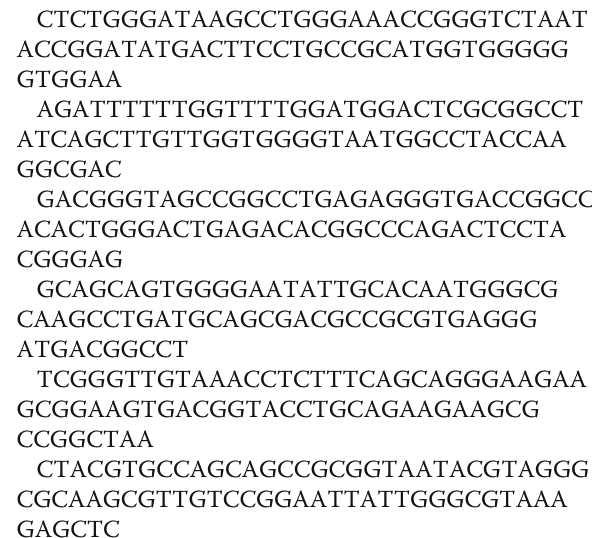
Results are expressed as antagonistic activity (mm) of the isolate bacteria against pathogenic compared to control (mean ± SD, n = 3). Values significantly different from control if * ρ <0.05 as analyzed by Student ’ s t -test. Control value for all the pathogenic bacteria 6